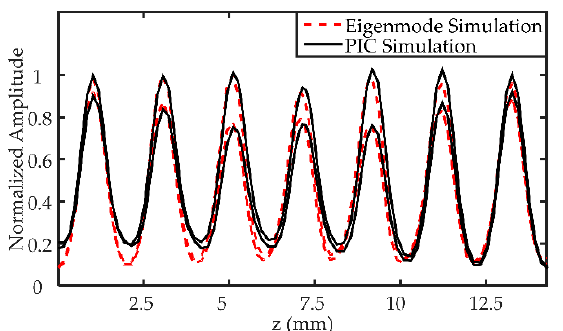
Figure 5. The comparison of field distribution curves between eigenmode simulation and PIC simulation, and both of them have been normalized.